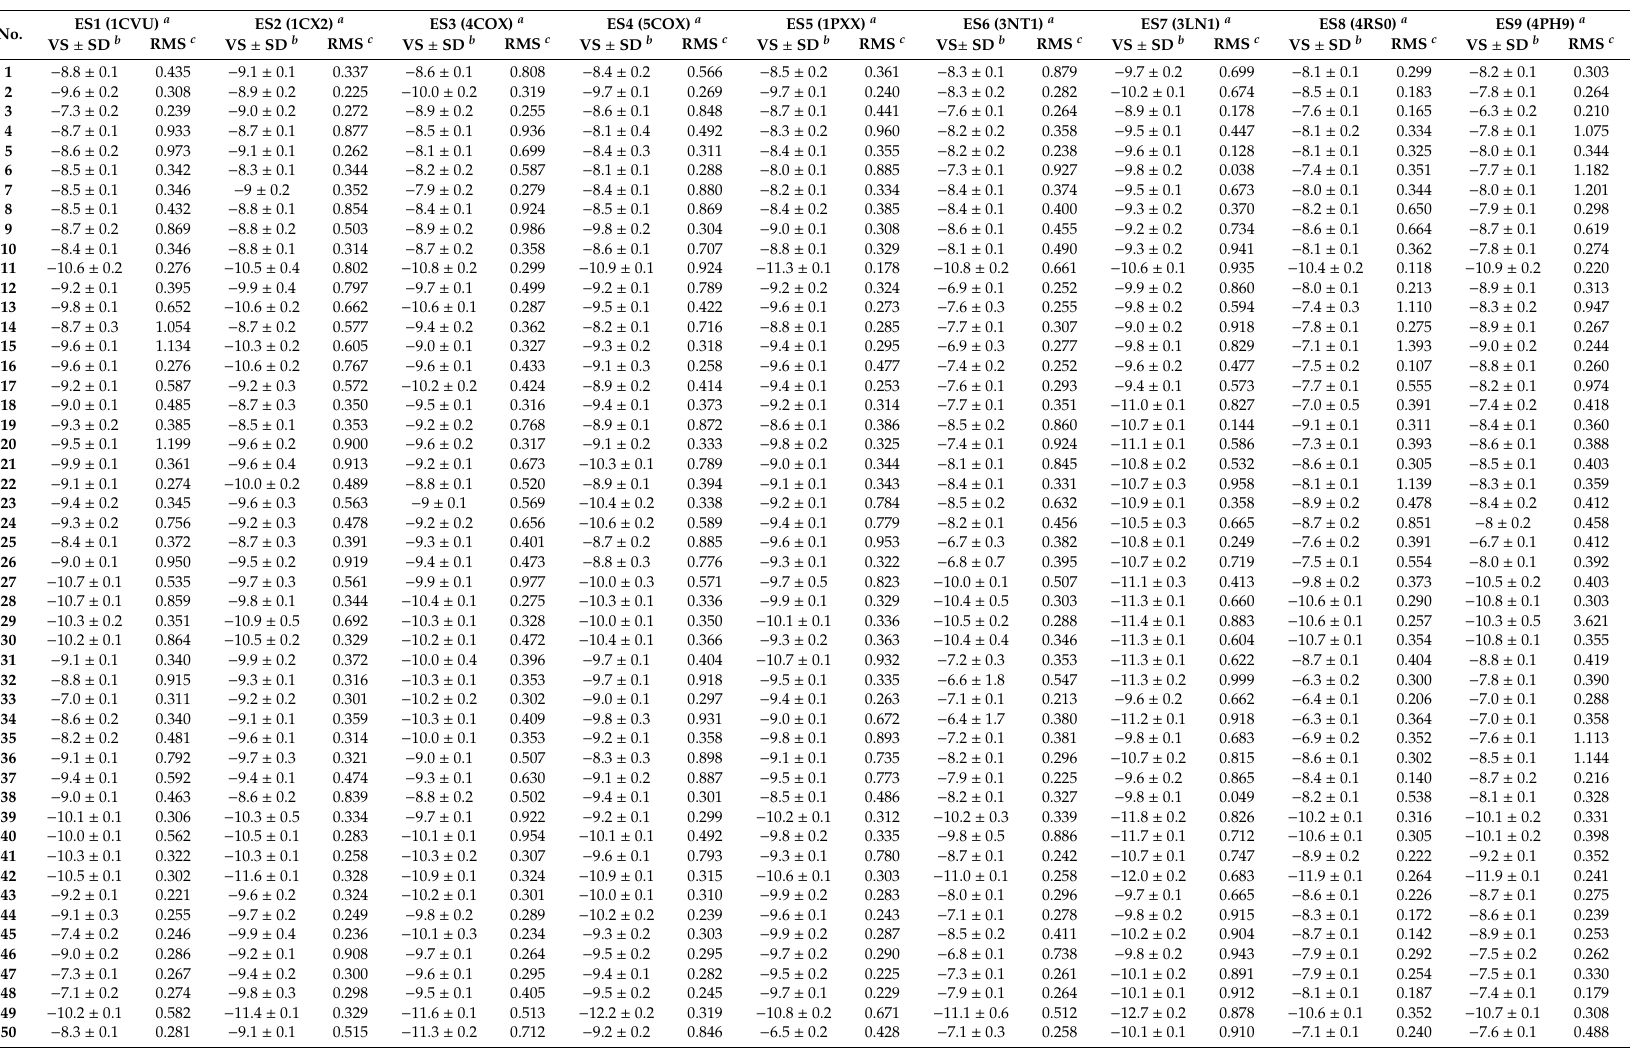
Table A2. Molecular docking results (Vina scores) of 2-arylbenzofuran-related compounds with